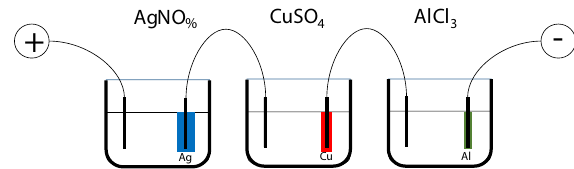
Figure 13. Demonstration of the experimental laws of Faraday on electrolysis (1834). Solutions of silver nitrate, copper sulphate and aluminium chloride. The electric current flowing through the cells is the same and the metal ions are deposited on the negative elec- trode in an amount proportional to the current flowing through the electrolytic cells (first Faraday’s Law). Furthermore, if the amount of silver deposited is 108 g (atomic weight of Ag) that of copper is equal to 31.7 g (about half the atomic weight of Cu) and that of alu- minium is 9 g (one third of the atomic weight of aluminium): this indicates that the Cu and Al ions, respectively, carry a double and triple charge with respect to that of the Ag ion (second Faraday’s Law) [16].